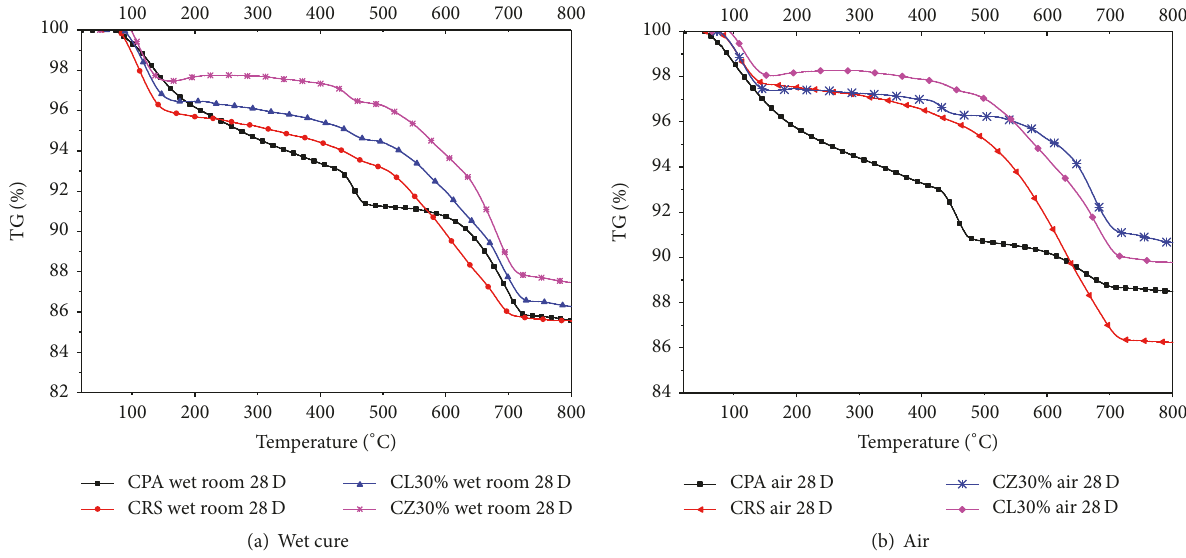
Figure 9: (a), (b) Thermogravimetric analysis of cement paste preserved in wet cure and stored in the air for 28 days.